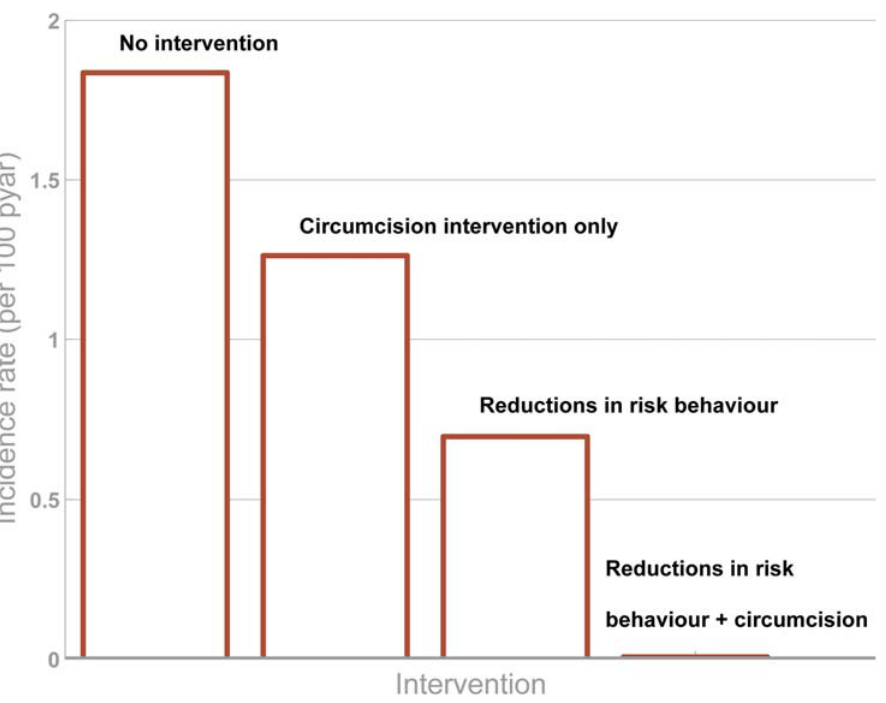
Figure 4. Interaction of circumcision interventions with existing behaviour change programmes. Four epidemic projections show: (i) no interventions, (ii) circumcision intervention with 90% coverage, (iii) a behaviour change intervention that leads to an average 30% reduction in partner change rate and 30% increase in condom use with casual partners, (iv) both the circumcision intervention and the behaviour change intervention. The output is HIV incidence per 100 person-years at risk (pyar). The time-scale relates to years since the circumcision intervention starts. (Note: Unlike in other simulations, here no compensation is made for the potential effects of AIDS mortality modifying the risk distribution in the population (see text S1 for